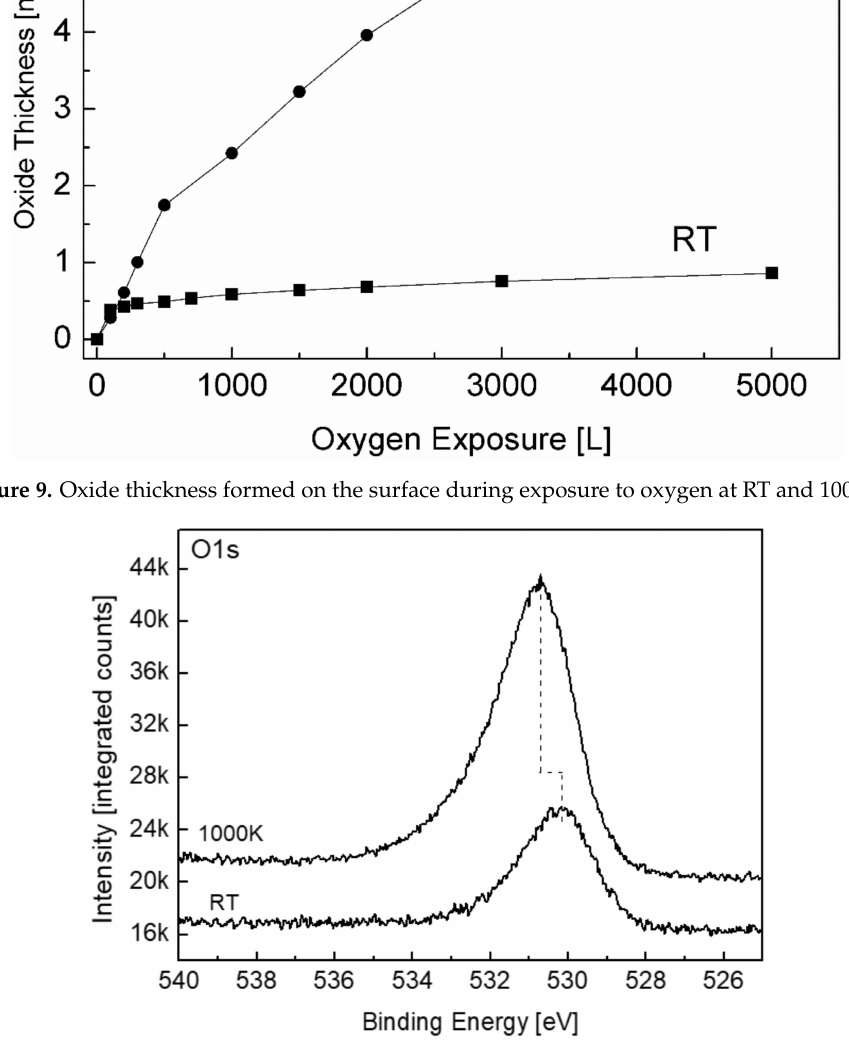
Figure 10. O1s spectra taken after exposure to 5000 L O 2 at RT and 1000